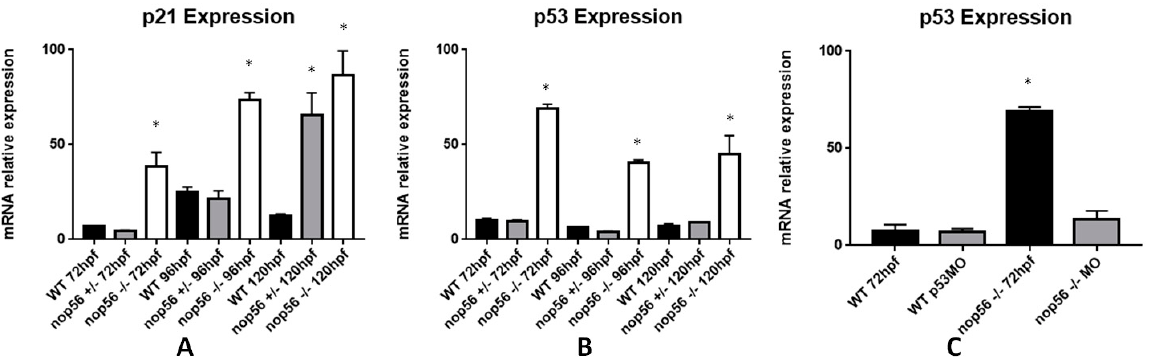
Figure 8. Apoptosis assay in wild type, nop56 +/ − and nop56 − / − . Fluorescence highlights apoptotic cells. nop56 − / − have a high increase in apoptosis mainly in CNS ( p -value < 0.0001). Statistically sig- nificant data in the graphs are indicated with a *.